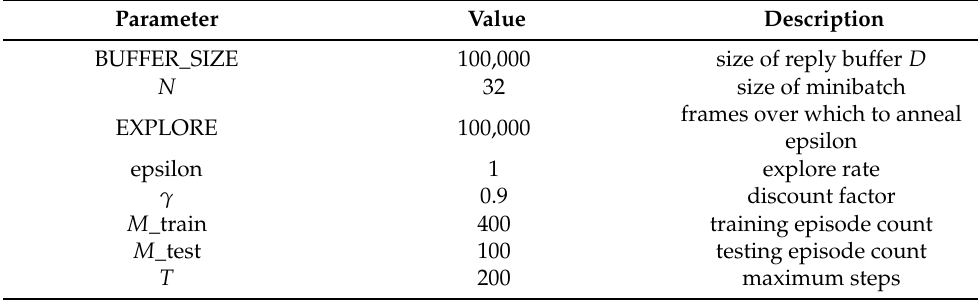
Table A1. Parameter